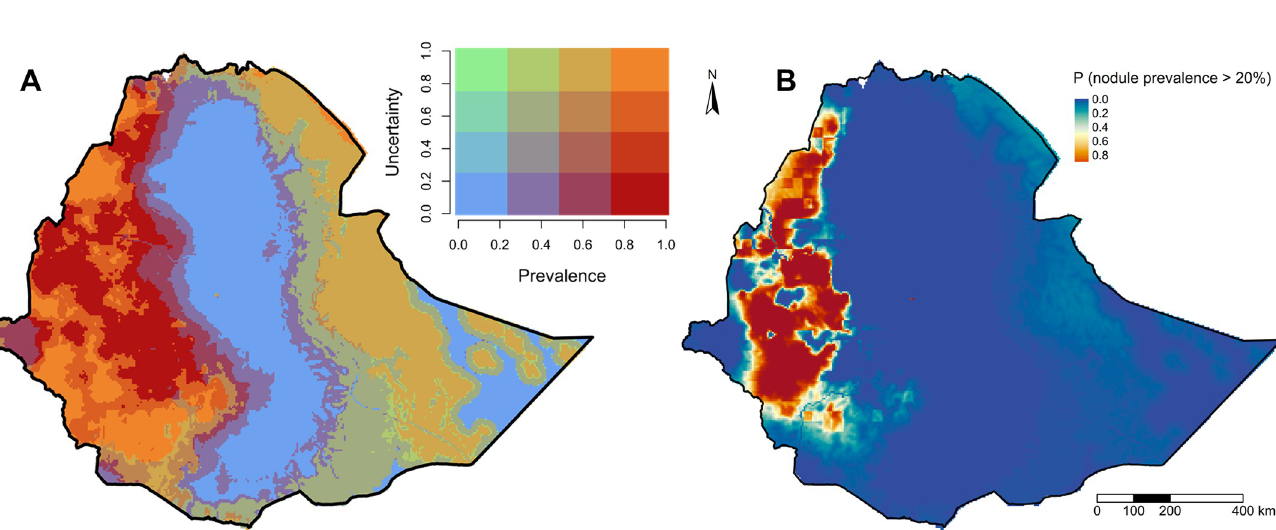
which is equivalent to 193.25 thousand km 2 .